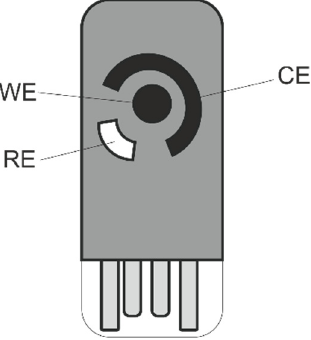
RE: reference electrode.